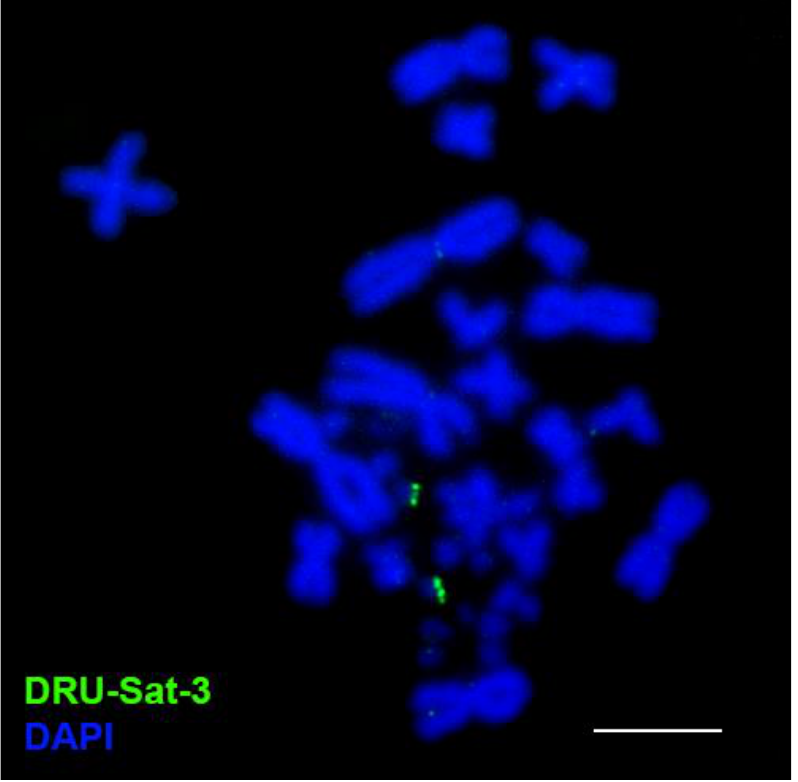
Figure 4. Localization of the satellite DRU-Sat-3 in the chromosomes of D. russelii. Scale: 10 μm.